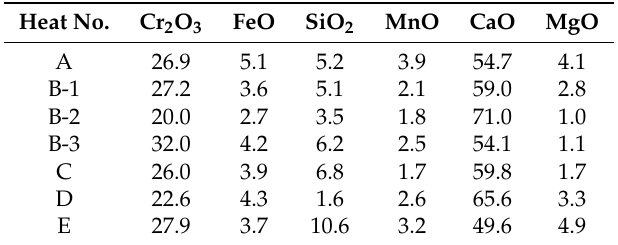
Table 3. The normalized XRF chemical composition for slags from five heats, where trace elements have been excluded